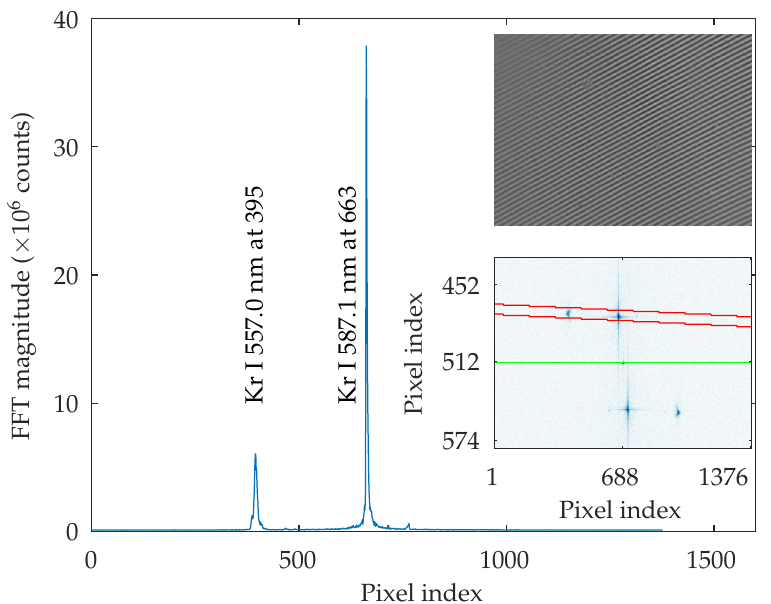
Figure 9. Spectrum of krypton calibration lamp from SHS. The interferogram of the lamp is given in the upper inset, and part of its 2D FFT is given in the lower inset, where the region of interest is defined by the red